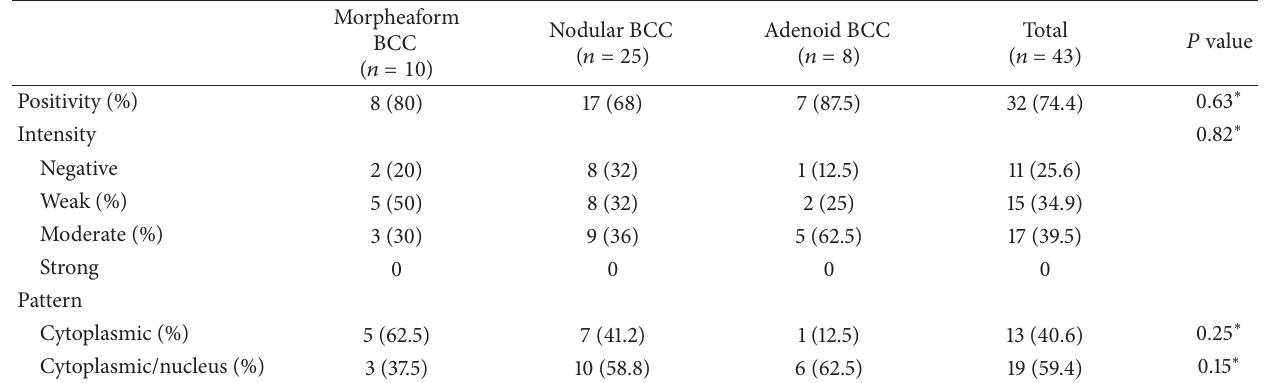
Table 2: Maspin protein expression among different types of periocular BCC.